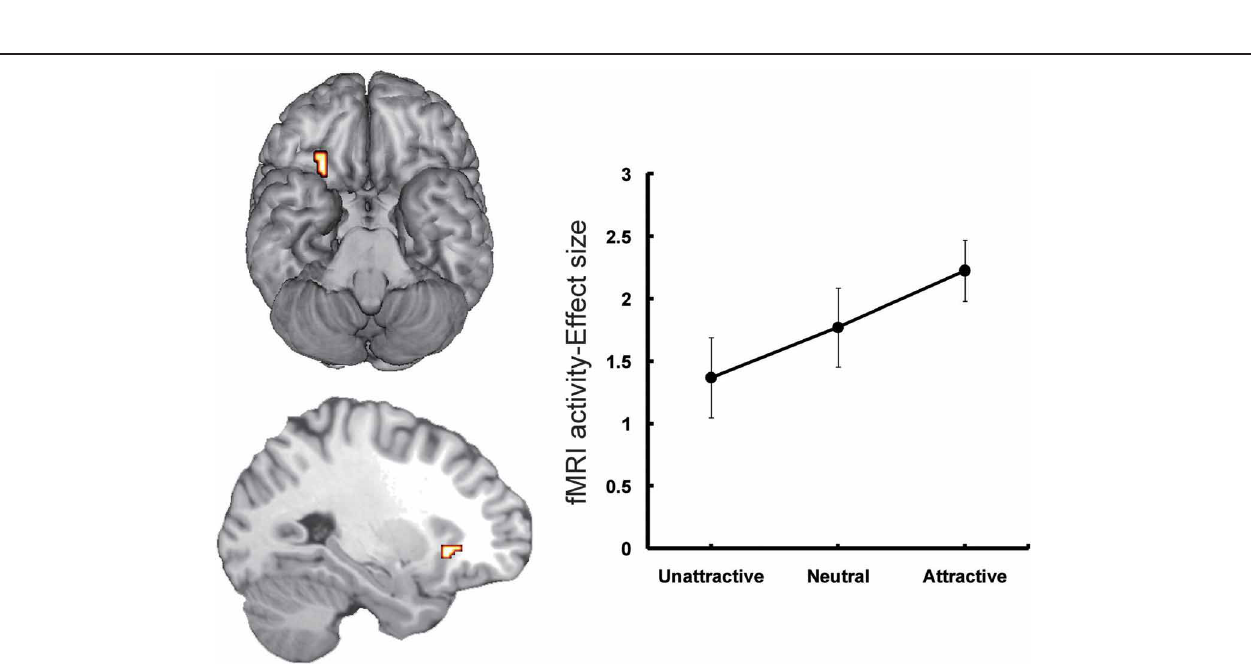
low-intensity expressions. (B) Activation profiles of the right amygdala. (C) Activation profiles of the left amygdala. This figure was reused with the permission.